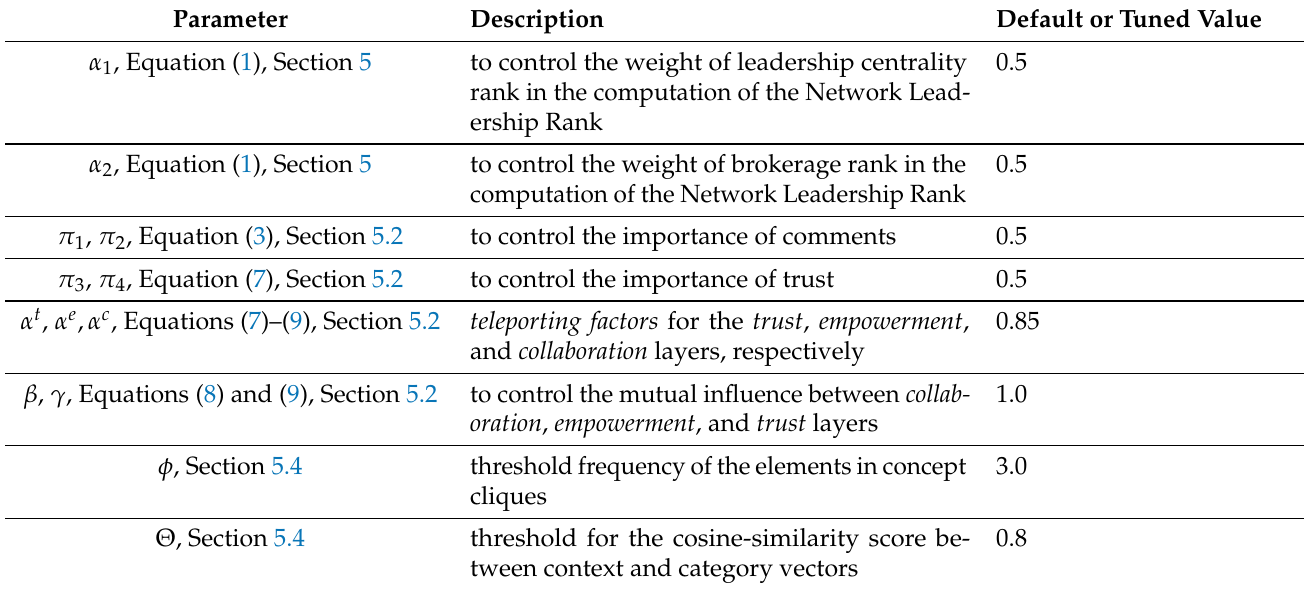
Table 1. Summary of the parameters of our computational model of Network Leadership. We remark that φ and Θ values were tuned to optimally perform Topic Leaders analysis with our